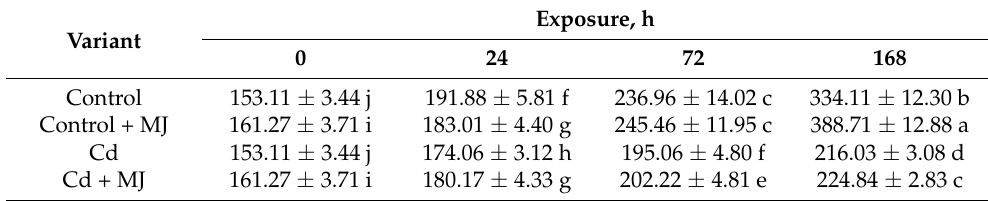
Table 3. Effect of MJ on fresh weight (g) of wheat seedlings.